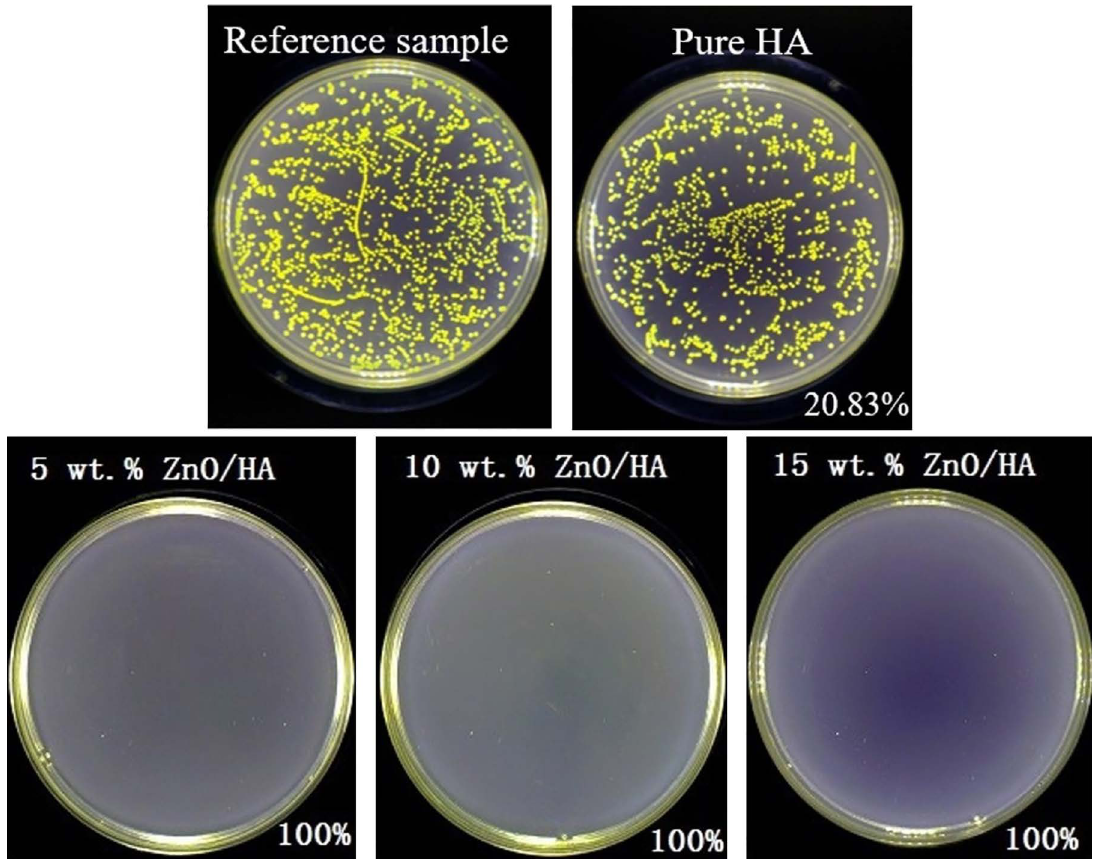
Figure 5. Antibacterial experiment photograph of the reference sample, pure HA and ZnO/HA